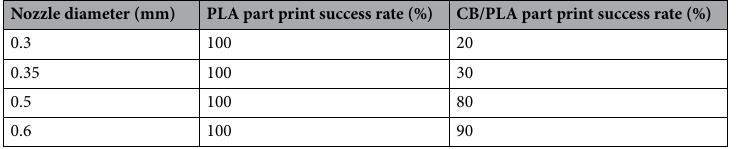
Table 1. Success rate of PLA and CB/PLA parts (using the same geometry of the electrodes) made using varying nozzle diameters, where n = 10. All printed parts were made at 50 °C heated bed temperature and 230 °C extruder temperature.